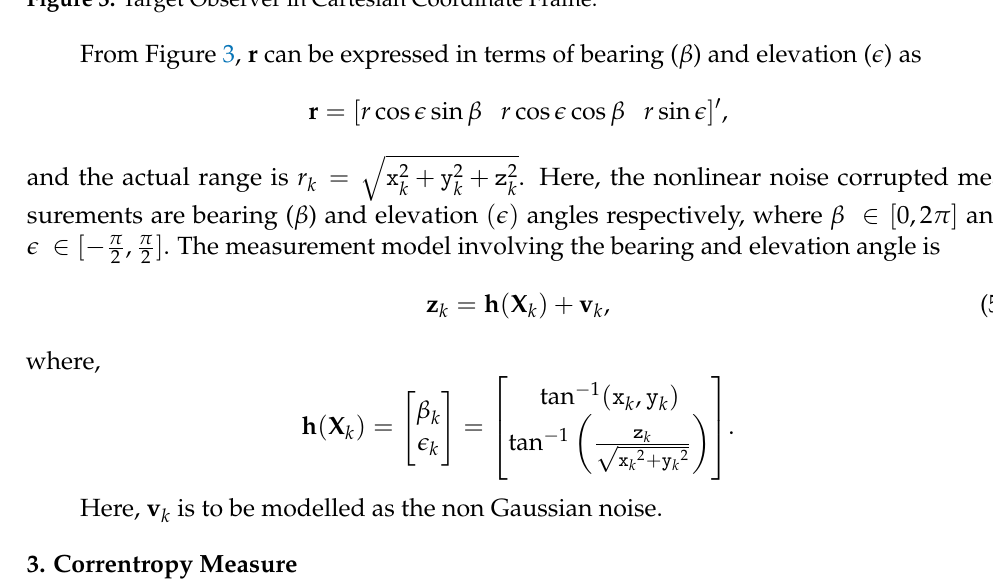
Figure 3. Target Observer in Cartesian Coordinate